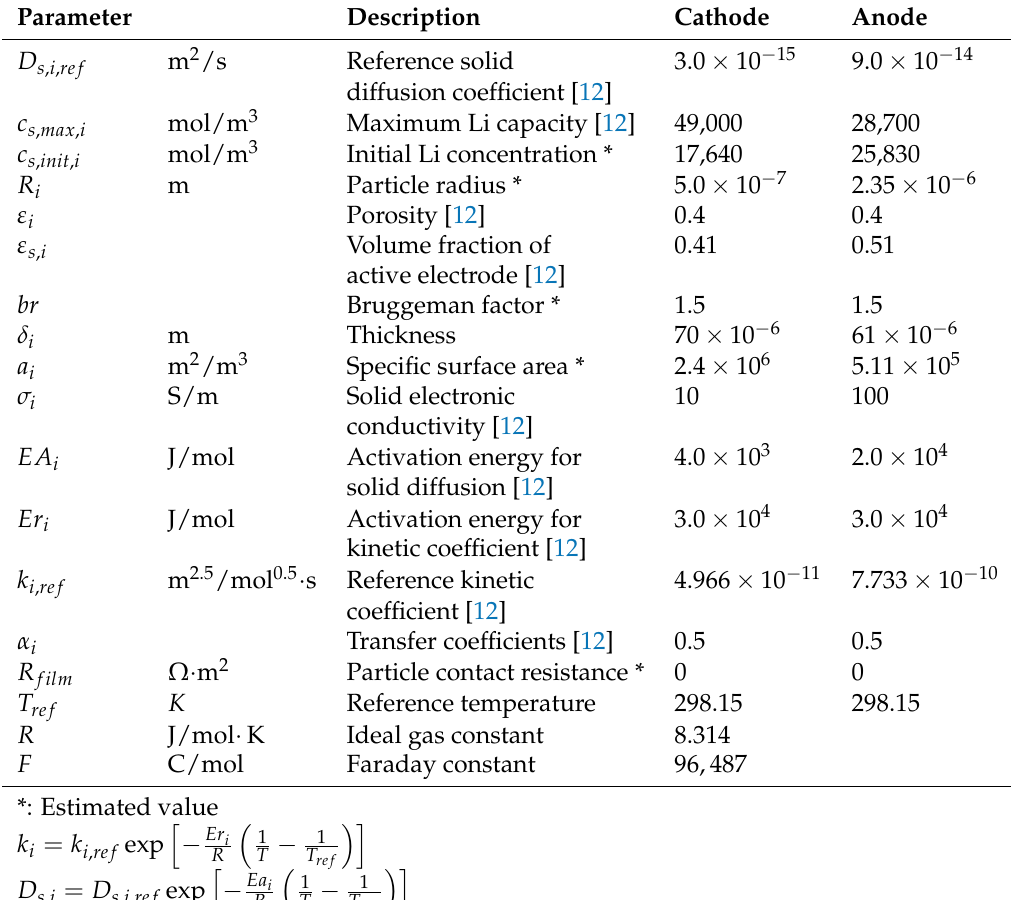
Table A2. List of electrode material parameters used in